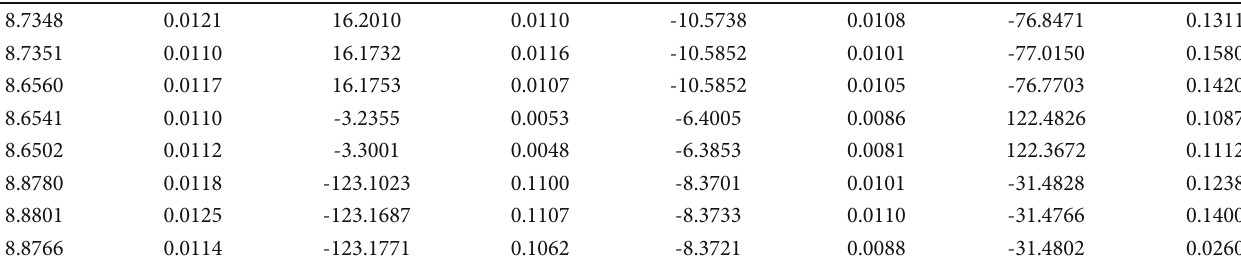
Table 1: Sensor data calibration.